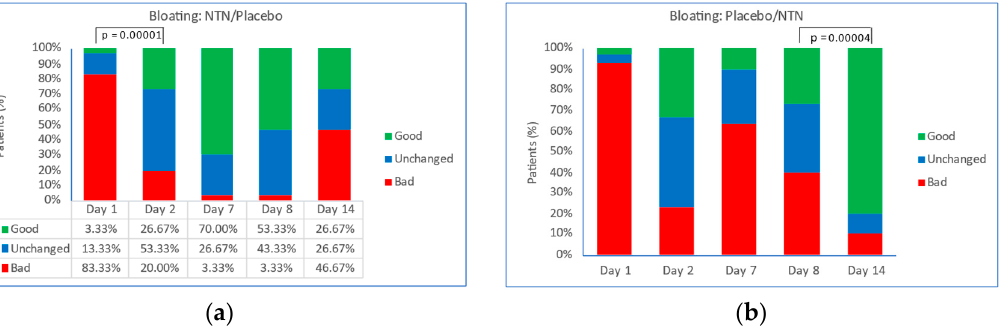
Figure 2. Evolution in bloating. Proportion of patients with good, unchanged, or bad Likert scores